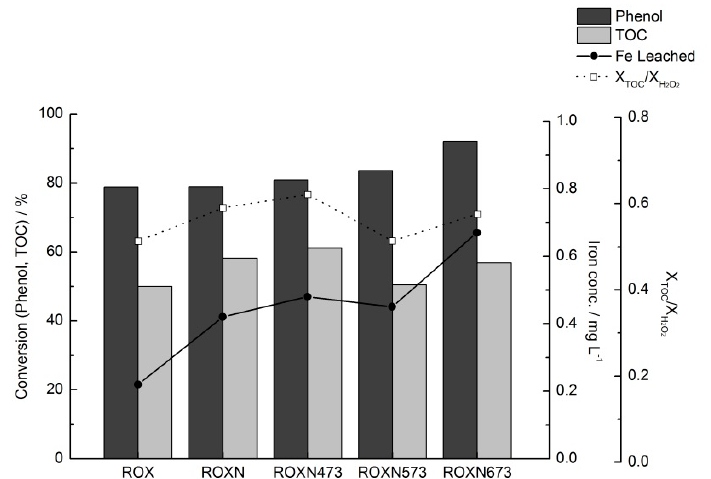
Figure 5. Conversions of phenol and TOC (respectively dark and light bars/left axis) and concentration of iron leached into solution and X TOC /X H2O2 (respectively squares and circles/right axis), obtained after 24 h in CWPO runs performed under the conditions given in Figure 2.